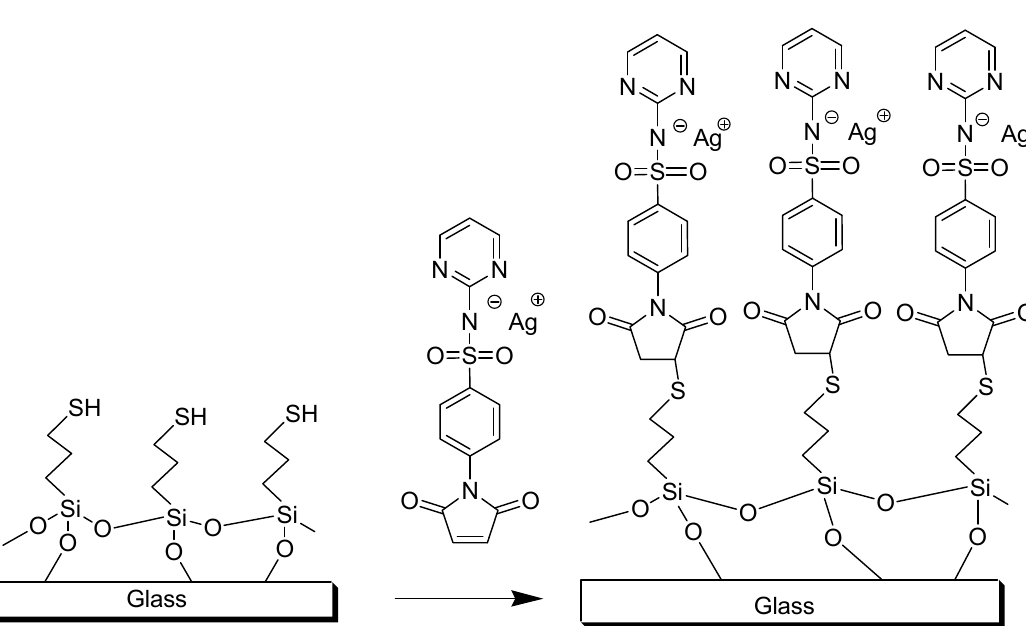
Scheme 3. Synthesis of SURF -Ag-SDM glasses.